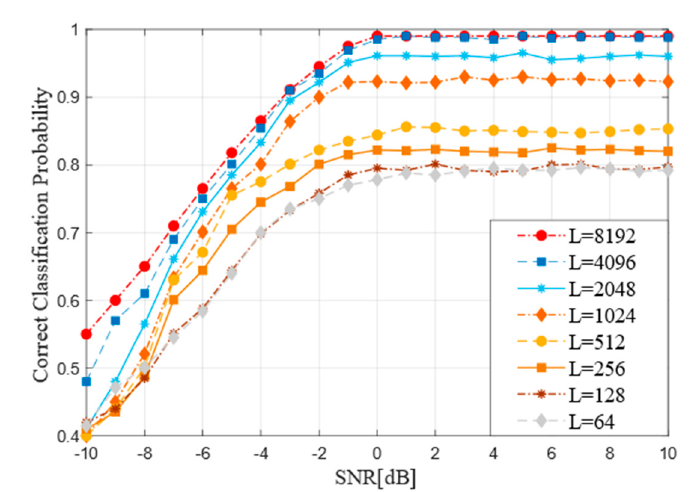
Figure 8. Recognition performance of the improved RNN in different lengths of input sample (L).